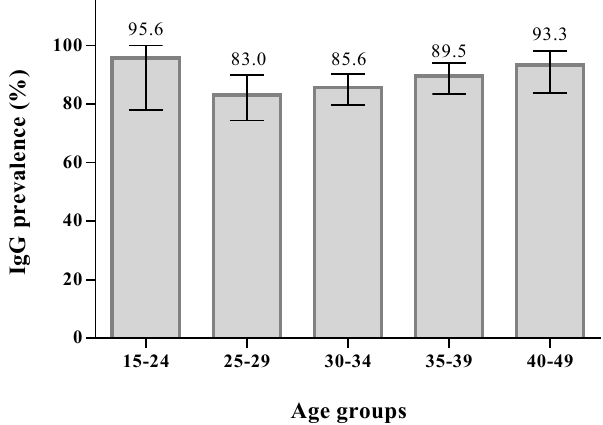
Figure 1. Prevalence of anti-VZV IgG antibodies in pregnant women by age groups: 95.6% (95% CI: 78.0–99.9) in 15–24 age group, 83.0% (95% CI: 74.2–89.8) in 25–29 age group, 85.6% (95% CI: 79.6–90.3)